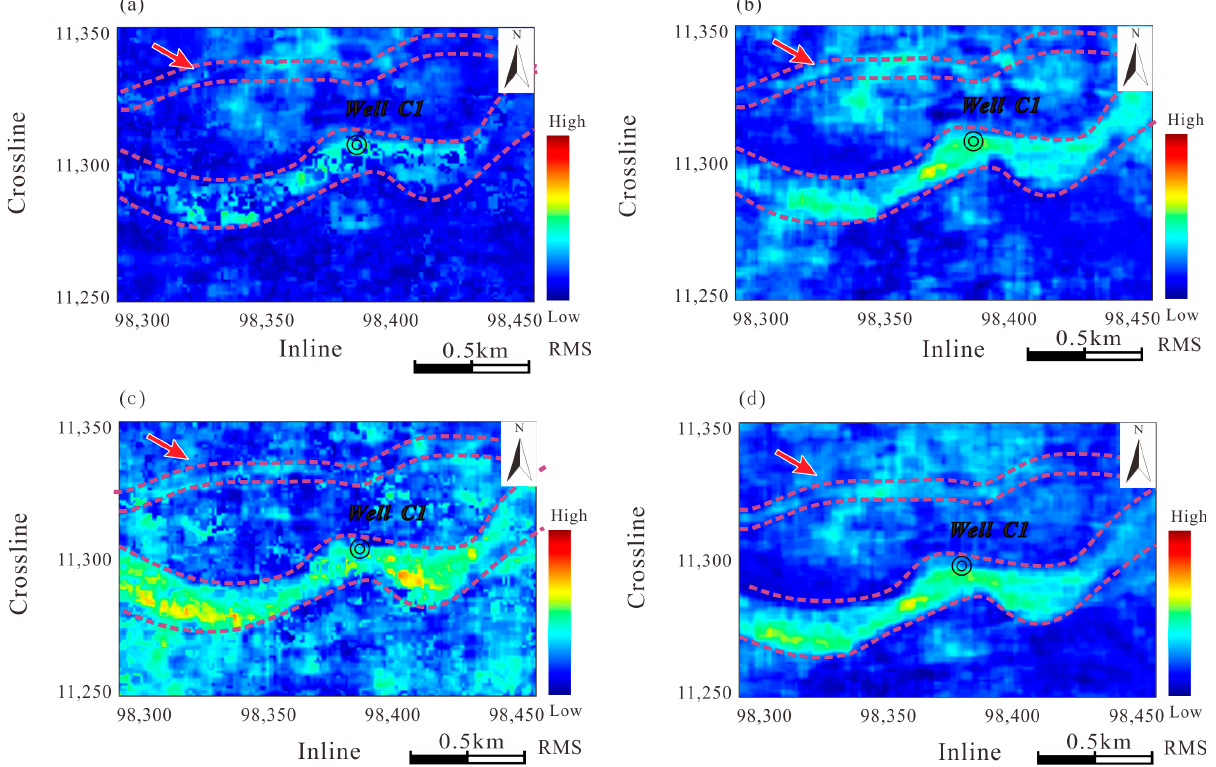
Figure 12. The detailed comparison in IMF2 and IMF3 components from the VMD and MT-VMD methods. Here, ( a , c ) are from Figure 10b,c, respectively; ( b , d ) are from Figure 11b,c, respectively. The original location of ( a – d ) are marked as white boxes in Figures 10 and 11.